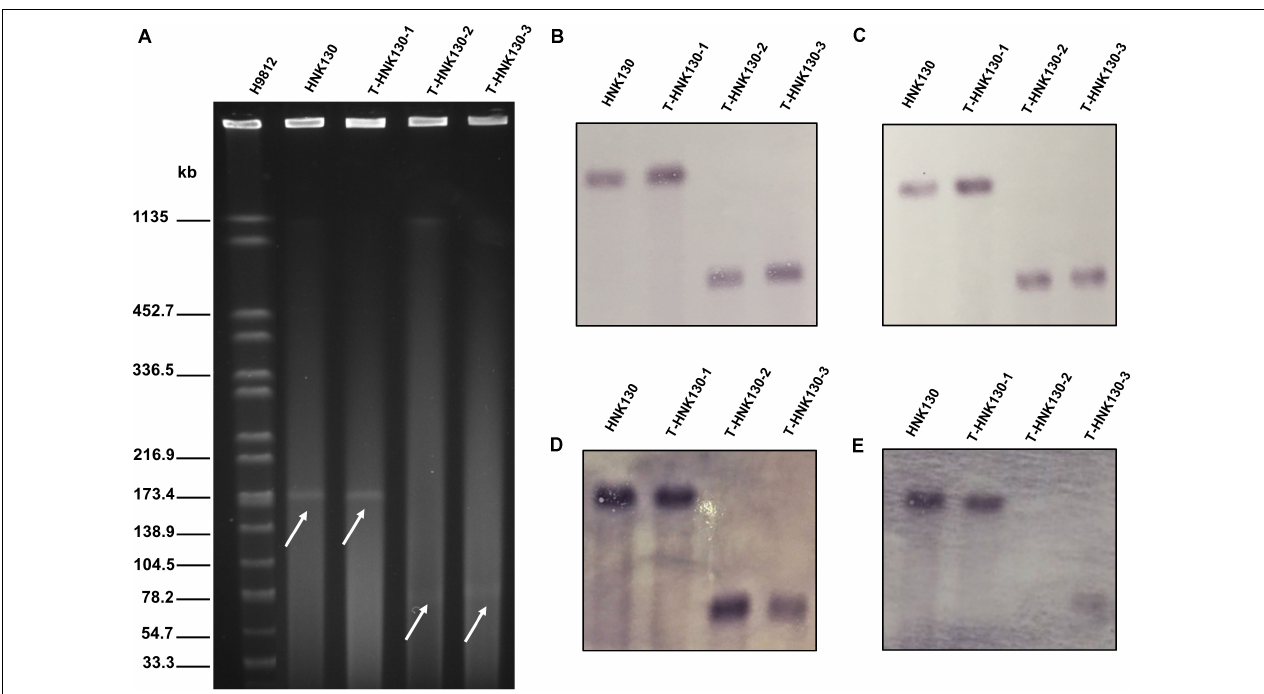
FIGURE 1 | Analysis of HNK130 and its fosA 3 -positive transformants. (A) S1-PFGE; (B) Southern hybridization with IncC-specific probe; (C) Southern hybridization with IncN-specific probe; (D) Southern hybridization with fosA3 -specific probe; (E) Southern hybridization with bla CTX − 9G -specific probe.